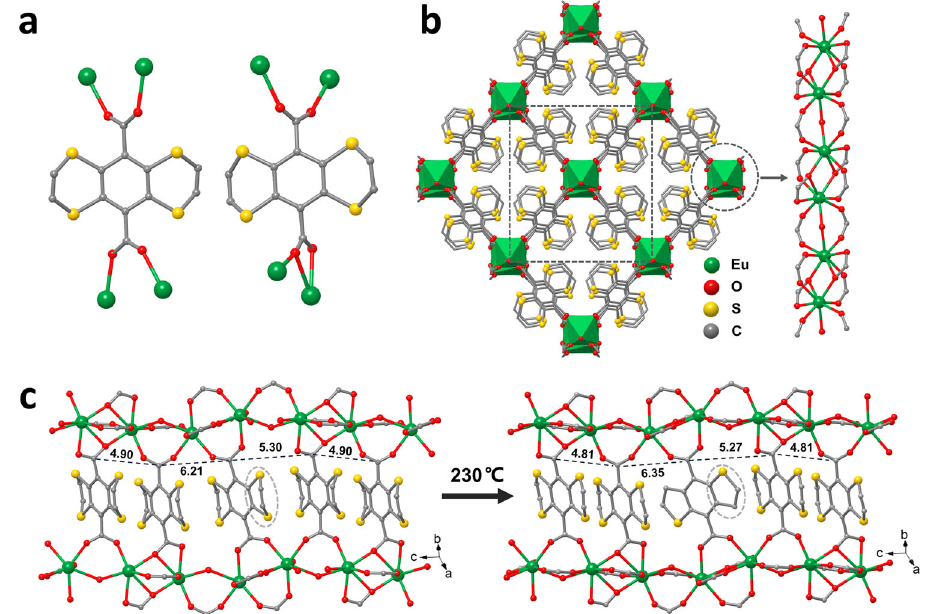
Fig. 2 | Single-crystal-to-single-crystal change from EuTTA to EuTTA-230. a Diagrammatic representation of the coordination environment of two types of coordination modesbetween carboxylate andEucenters. b Aview of EuTTA along the c axis. c The side view ofa stack of the linkermolecules and the two associated